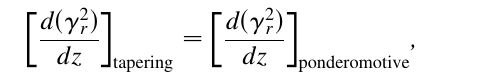
along the undulator. w